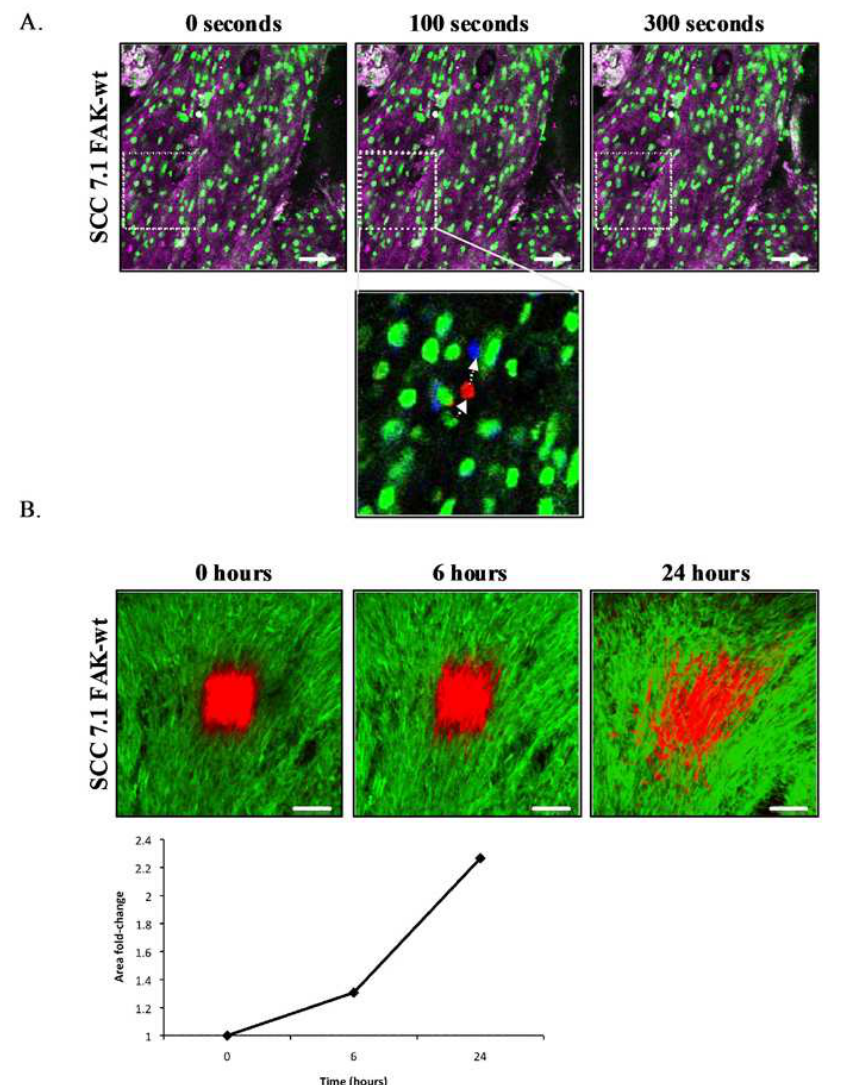
Figure 7. Intravital in vivo photoswitching to monitor tumor invasion. ( A ) Images from a time series acquired from a GFP expressing squamous cell carcinoma (SCC) xenograft expressing wild-type FAK (green: GFP, purple: confocal reflectance of extracellular tissue), scale bar 50 µ m. Lower panel represents co-localized images from the time-series showing tracked single cell movement within tumors (green, 0 seconds; red, 100 seconds; blue, 300 seconds). White arrows indicate direction of cell movement. ( B ) Images represent Dendra2 labeled SCC FAK-wild-type expressing cells imaged using optical window chambers at 0, 6, and 24 hours post photo-switching (green, unswitched; red, switched). Scale bar 100 µ m. Graph represents quantification of the total area covered by red fluorescence at sequential time-point following